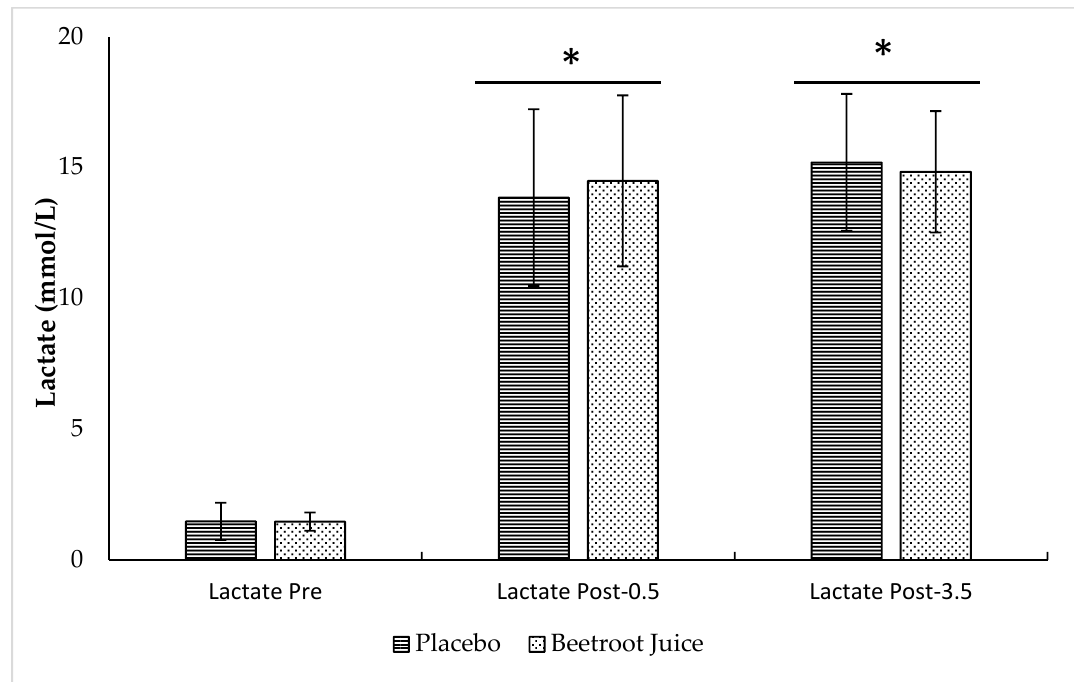
Figure 5. Blood lactate concentrations recorded after the sprint for the placebo and BJ conditions. Values are means ± standard deviation. * p < 0.05 compared to Pre. Pre, before sprint exercise; Post ‐ 0.5, 0.5 min post ‐ exercise; Post ‐ 3.5, 3.5 min post ‐ exercise.